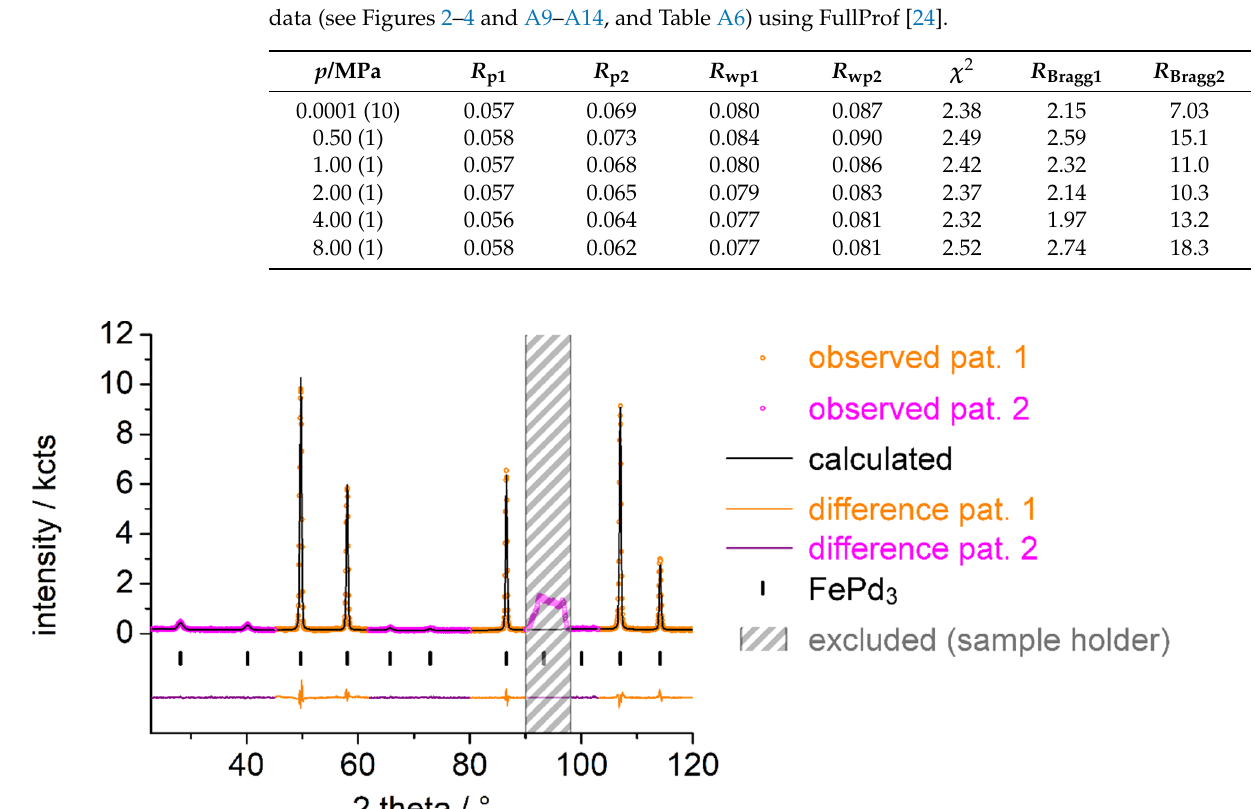
Figure A8. Rietveld refinement of the crystal structure of FePd 3 (for details, see first row in Tables A6 and A7) based on neutron powder diffraction data (NUMOR 131613 [21], λ = 186.80(2) pm, D20 ILL, Grenoble) in a single-crystal sapphire cell at 296(1) K and applied vacuum (0.0001(10) MPa) using FullProf [24].